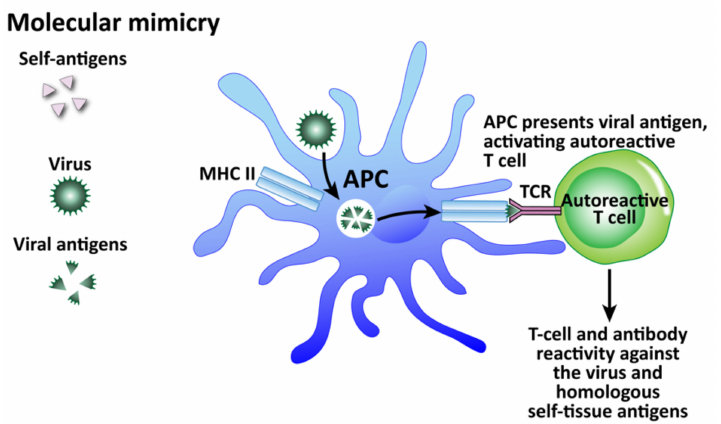
Figure 11. How viruses can induce autoimmunity through molecular mimicry. Viruses are taken up by APCs and broken up into viral antigens that are structurally similar to self-antigen. When the APC primes the T cell with the viral antigen, it becomes an autoreactive T cell and attacks both viruses and self-tissue.